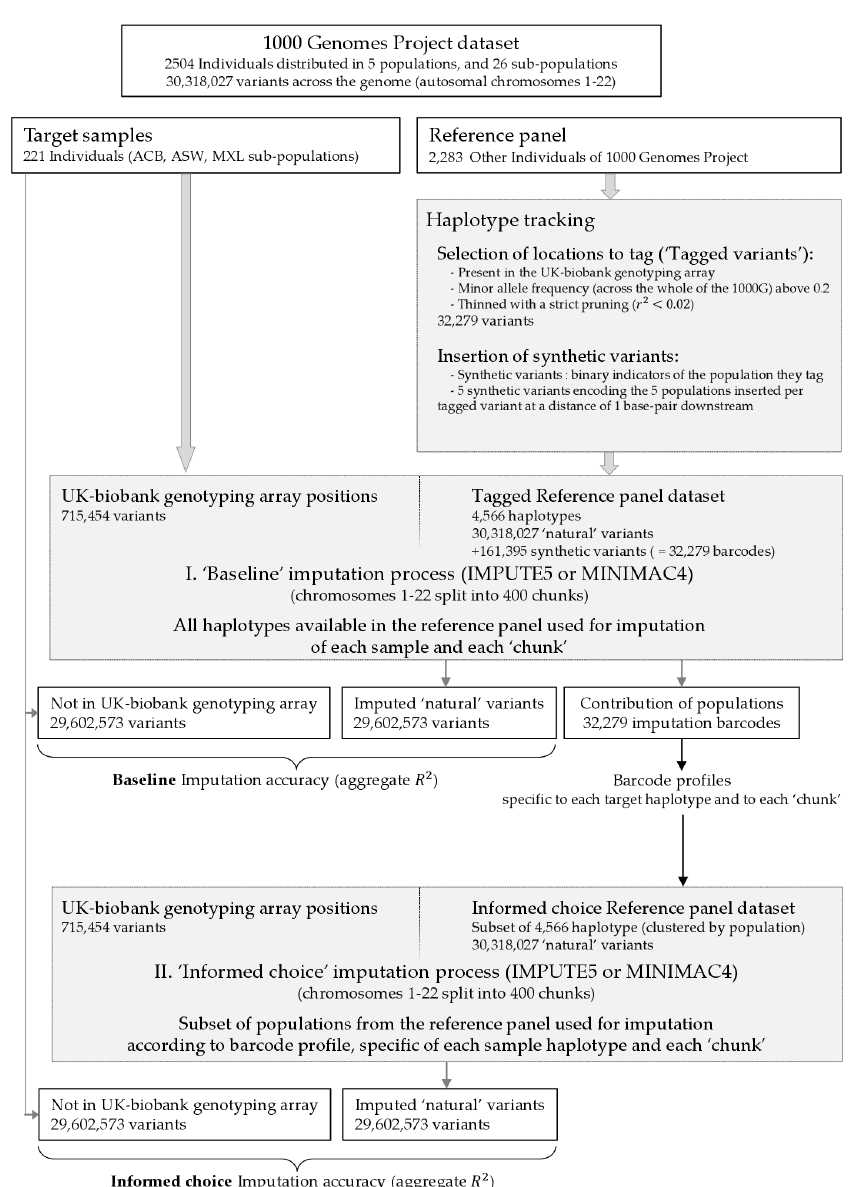
Figure 1. Schematic of the insertion of synthetic variants (imputation barcodes) and the informed choice imputation strategy.